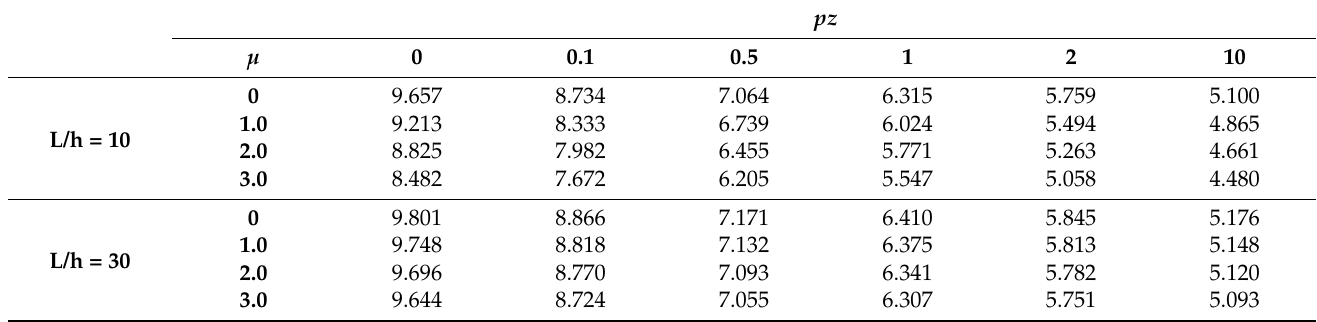
Table 3. Nondimensional fundamental frequencies ( Ω adim ) of SS FGM1-Z beams.